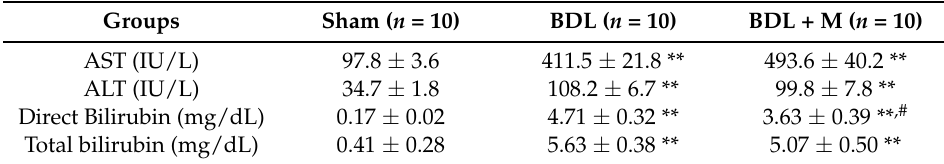
Table 1. Plasma liver function profiles in different experimental groups.